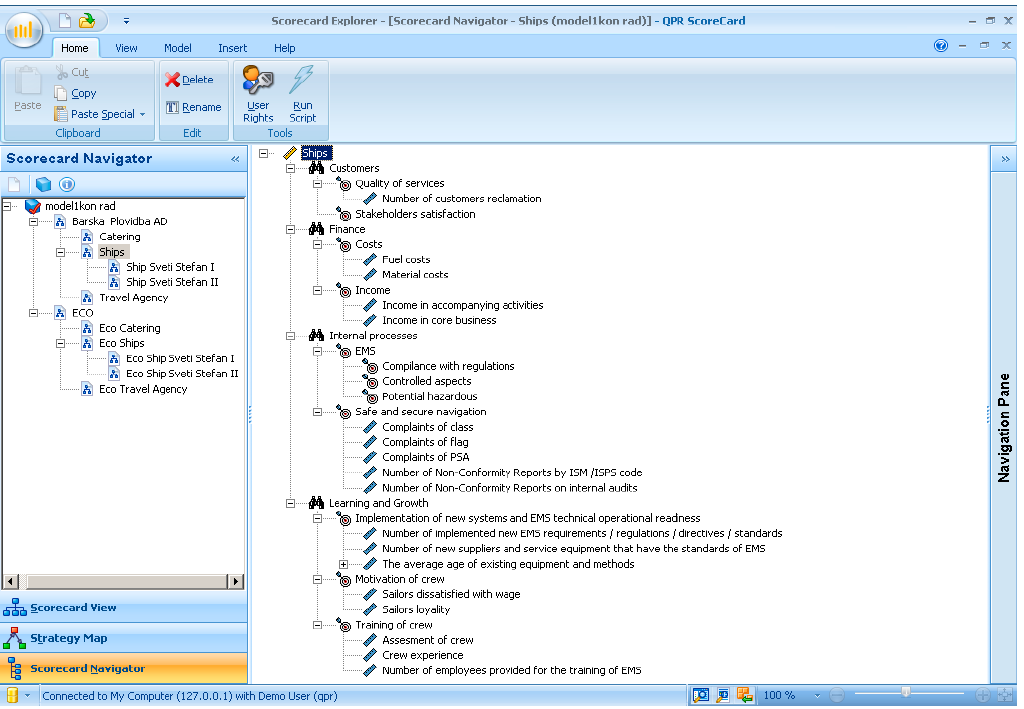
Figure 4. Model 1: Connection between conventional BSC and ECO BSC by involving key Figure4. Model1: ConnectionbetweenconventionalBSCandECOBSCbyinvolvingkeyenvironmental environmental objectives and measures into existed perspectives of conventional BSC model. objectives and measures into existed perspectives of conventional BSC